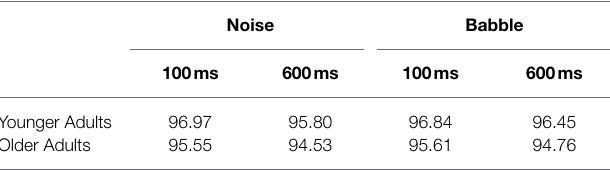
TABLE 1 | Average percentage correct word identification performance by Condition (Noise or Babble) and Delay (100 or 600 ms) for all 24 Older and 24 Younger